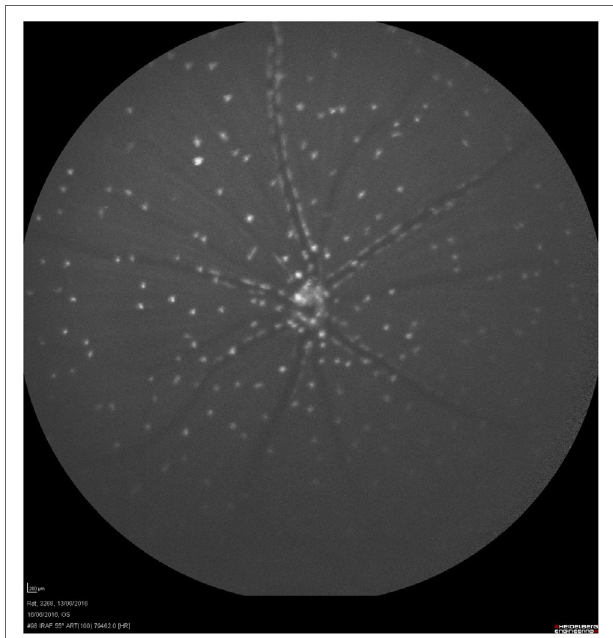
FiGURe 1 | Visualization of nerve cell apoptosis. Retinal ganglion cell (RGC) apoptosis could be detected in vivo by using a modified cLSO with an argon laser (488 nm) for illumination and a wide band­pass filter with short­ wavelength cutoff of a 521­nm filter and intravitreal Alexa­Fluor 488 fluorescent­labeled annexin 5. This was a model of staurosporine (SSP)­ induced apoptosis. This rat’s eye was treated with intravitreal SSP (0.5 µg). This retinal image shows extensive RGC apoptosis (white spots, annexin 5­positive apoptotic